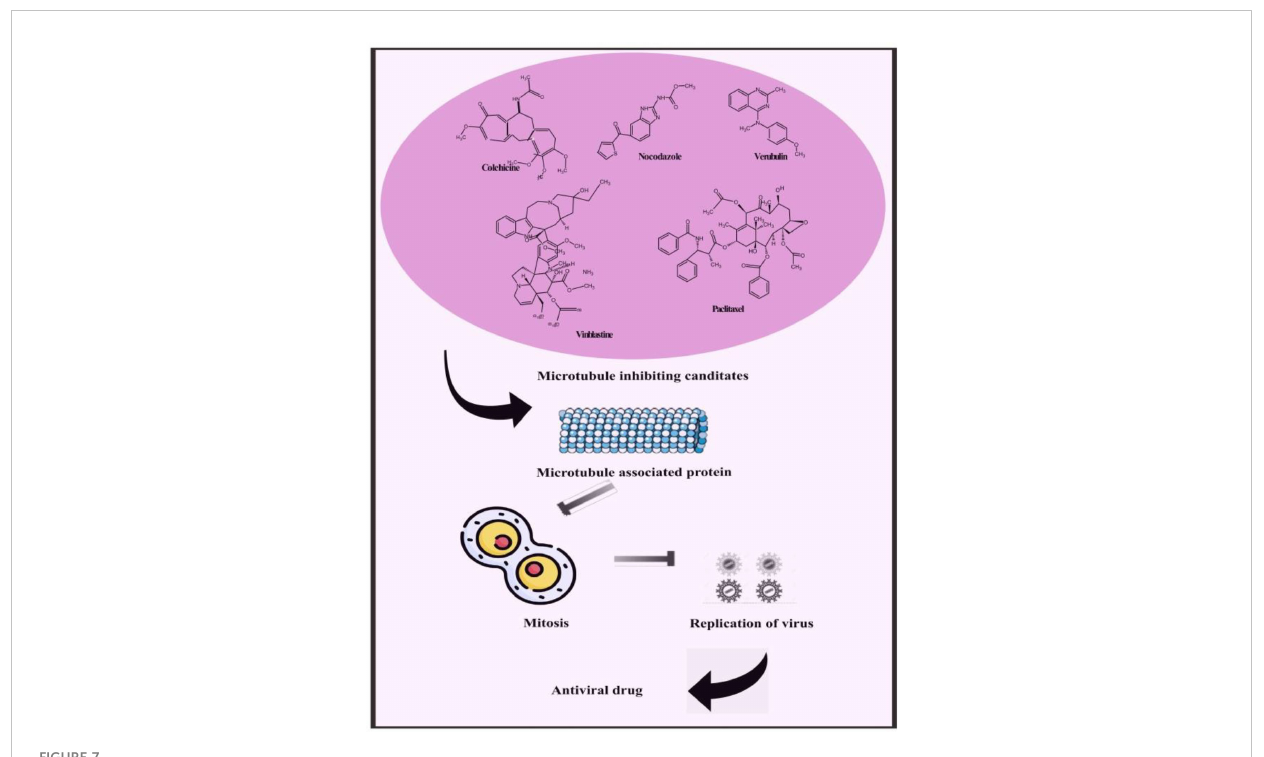
FIGURE 7 Representing possible leads constituents to mitigate monkeypox by microtubule inhibiting